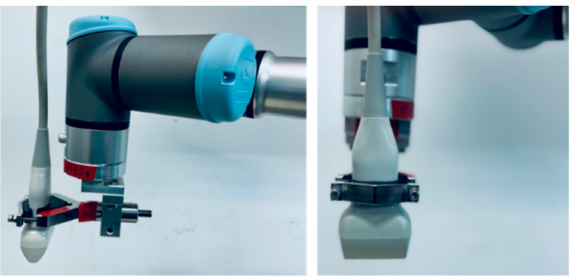
Figure 3. The ultrasonic probe of a conventional B-mode ultrasound scanner attached to the robotic arm.